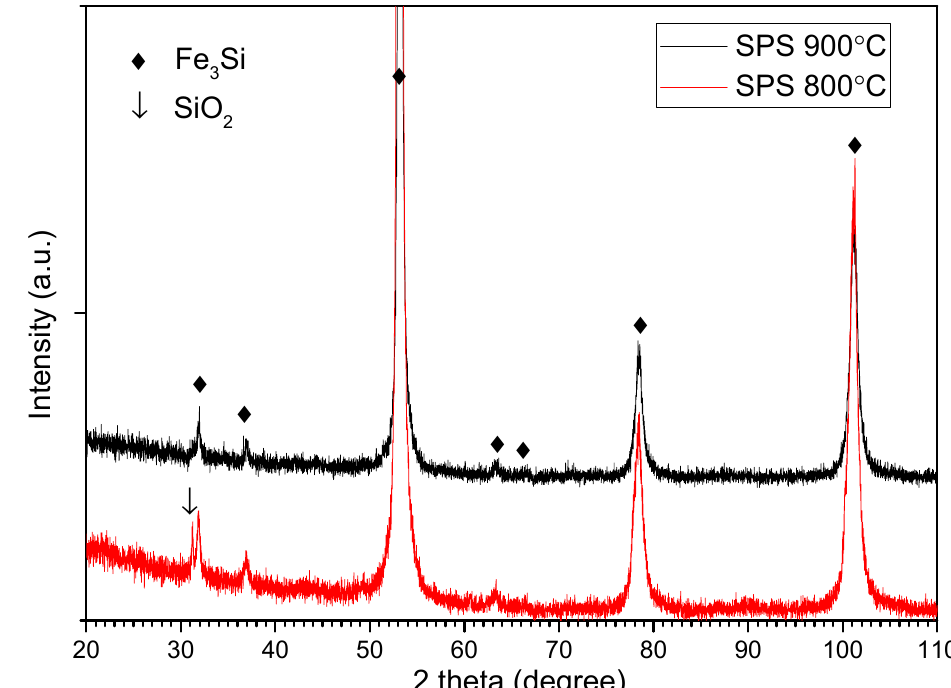
Figure 7. X-ray diffraction patterns of the compacts densified by spark plasma sintering.